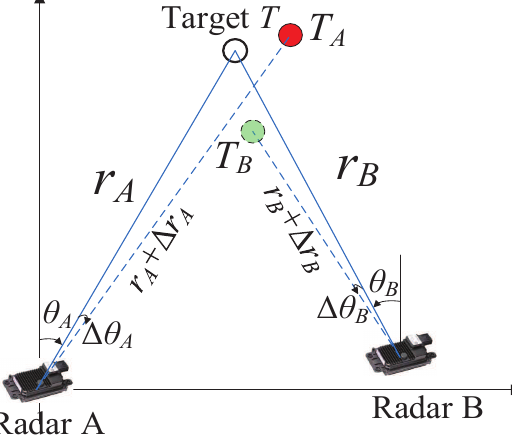
Figure 1. Relationship between sensor bias and local